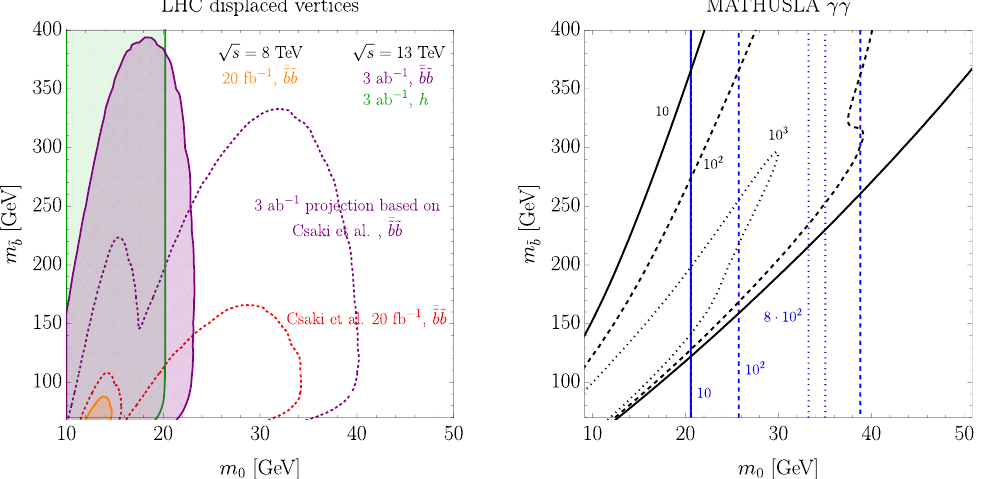
Figure 6 . (Left) Current and projected LHC constraints on the 0 ++ glueball mass m bottom mass m ~ from searches for displaced vertices, for (cid:24) = 0 : 1. The bounds shown correspond b to 0 ++ production from annihilation of twin-bottom bound states at 8 TeV in 20 fb (cid:0) 1 of ATLAS data [65] (orange), and projected searches from [66] at 13 TeV with 20 fb (cid:0) 1 (dotted red) and 3 ab (cid:0) 1 (dotted purple), as well as from the HL-LHC [67, 68] (purple). Shown also the HL-LHC